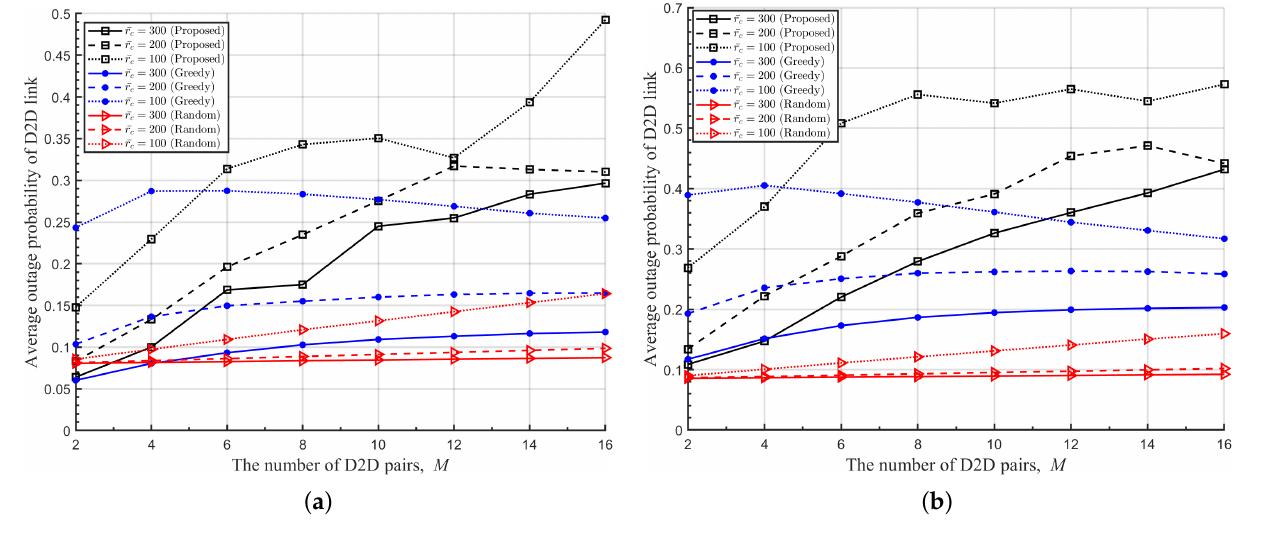
Figure 9. Average outage probability of D2D links with respect to M for various ¯ r c . ( a ) R c = 6 [bits/s/Hz], ( b ) R c = 8 [bits/s/Hz].